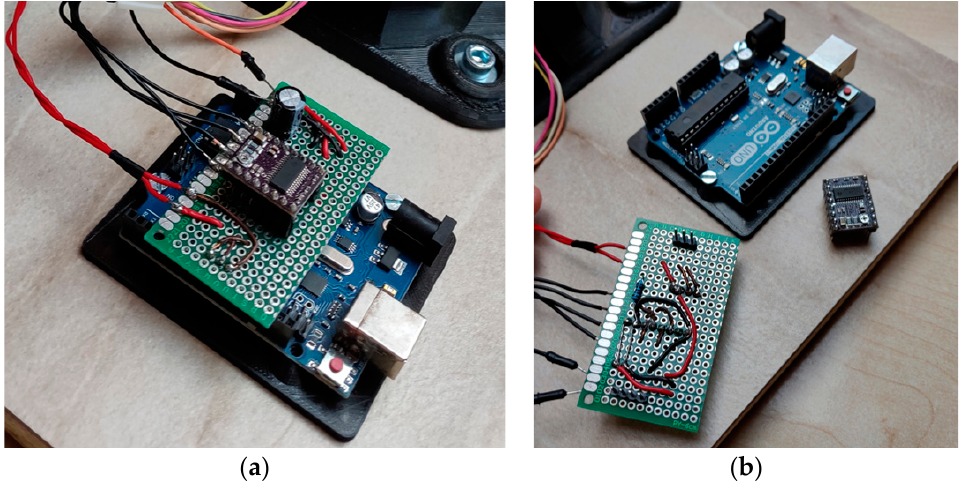
Figure 10. ( a ) The electronic assembly developed to control the stepper motor; ( b ) Arduino microcontroller, stepper motor driver DRV8825, and the electronic assembly.